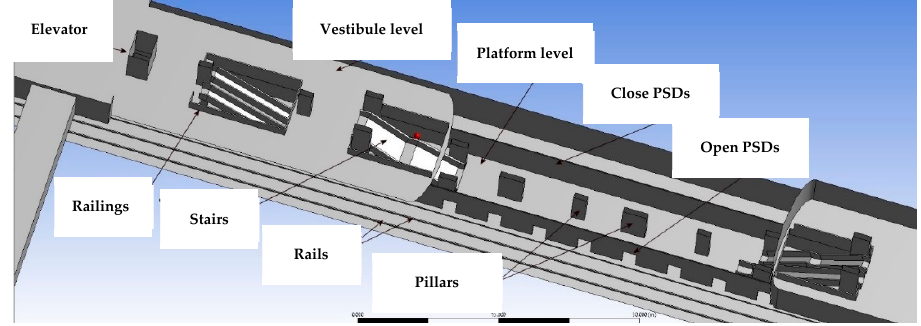
Figure 9. Subway station geometry in the numerical model.